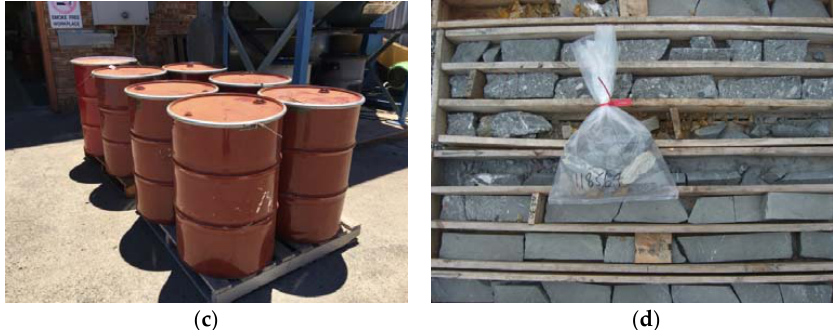
Figure 5. ( a ) Plastic buckets (25 kg capacity), ( b ) metal core trays, ( c ) 205 litre drums (250–350 kg